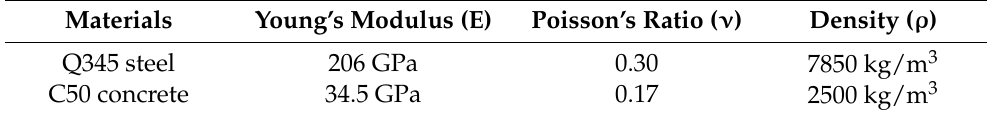
Figure 3. The constructed finite element model of a steel truss bridge. Table 1. The material parameters. Table 1. The material